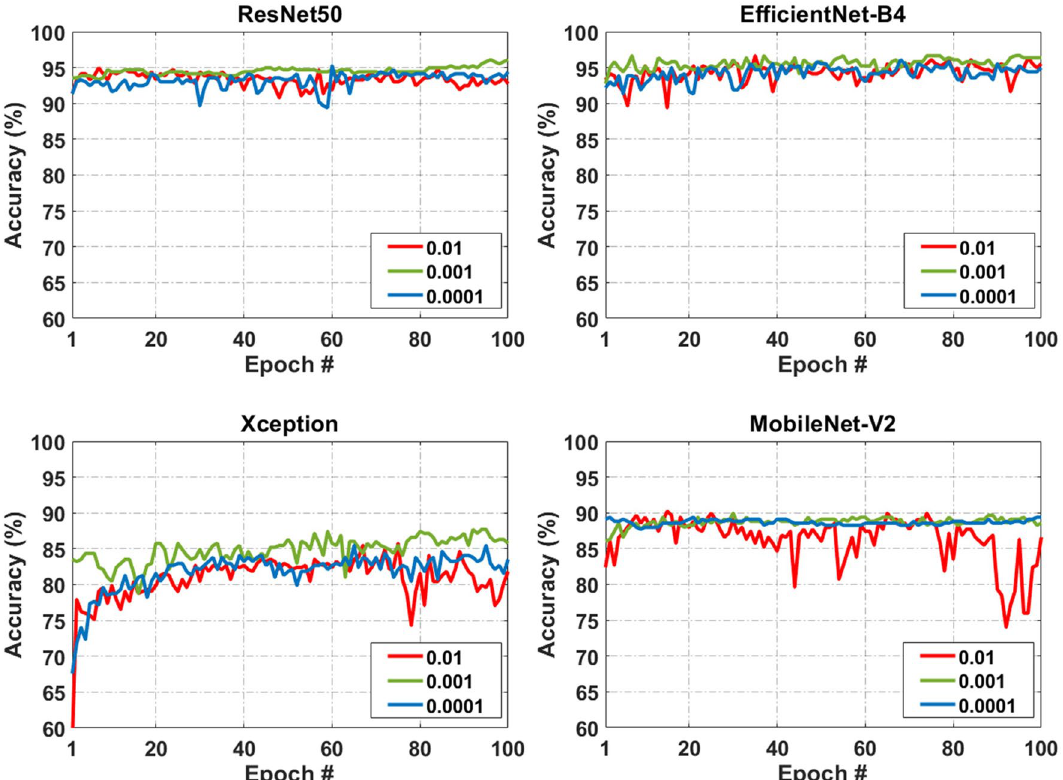
Figure 2. The effect of different learning rates (0.01, 0.001, and 0.0001) on the accuracy of the residual networks (ResNet), Xception, EfficientNetB4, and MobileNetV2 pre-trained conventional neural network (CNN) models using different epoch numbers where Adaptive Moment Estimation (Adam) was used as the optimizer of the